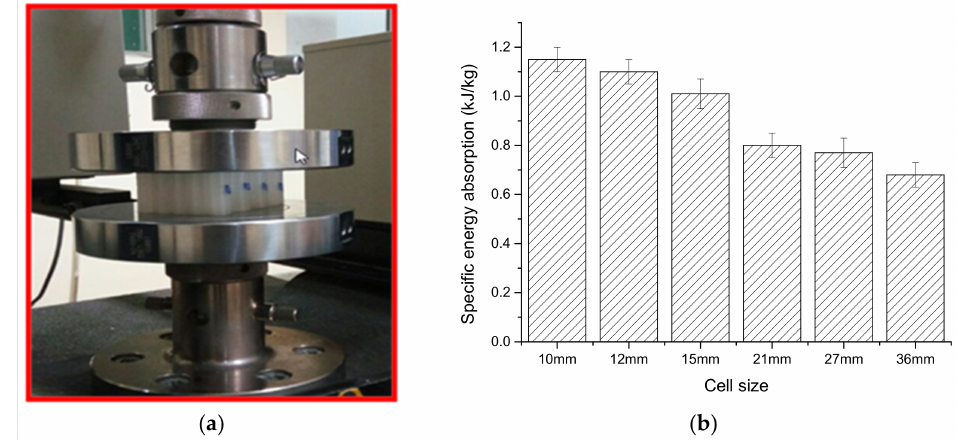
Figure 18. ( a ) Compression test setup; ( b ) Specific energy absorption vs. cell size [171].